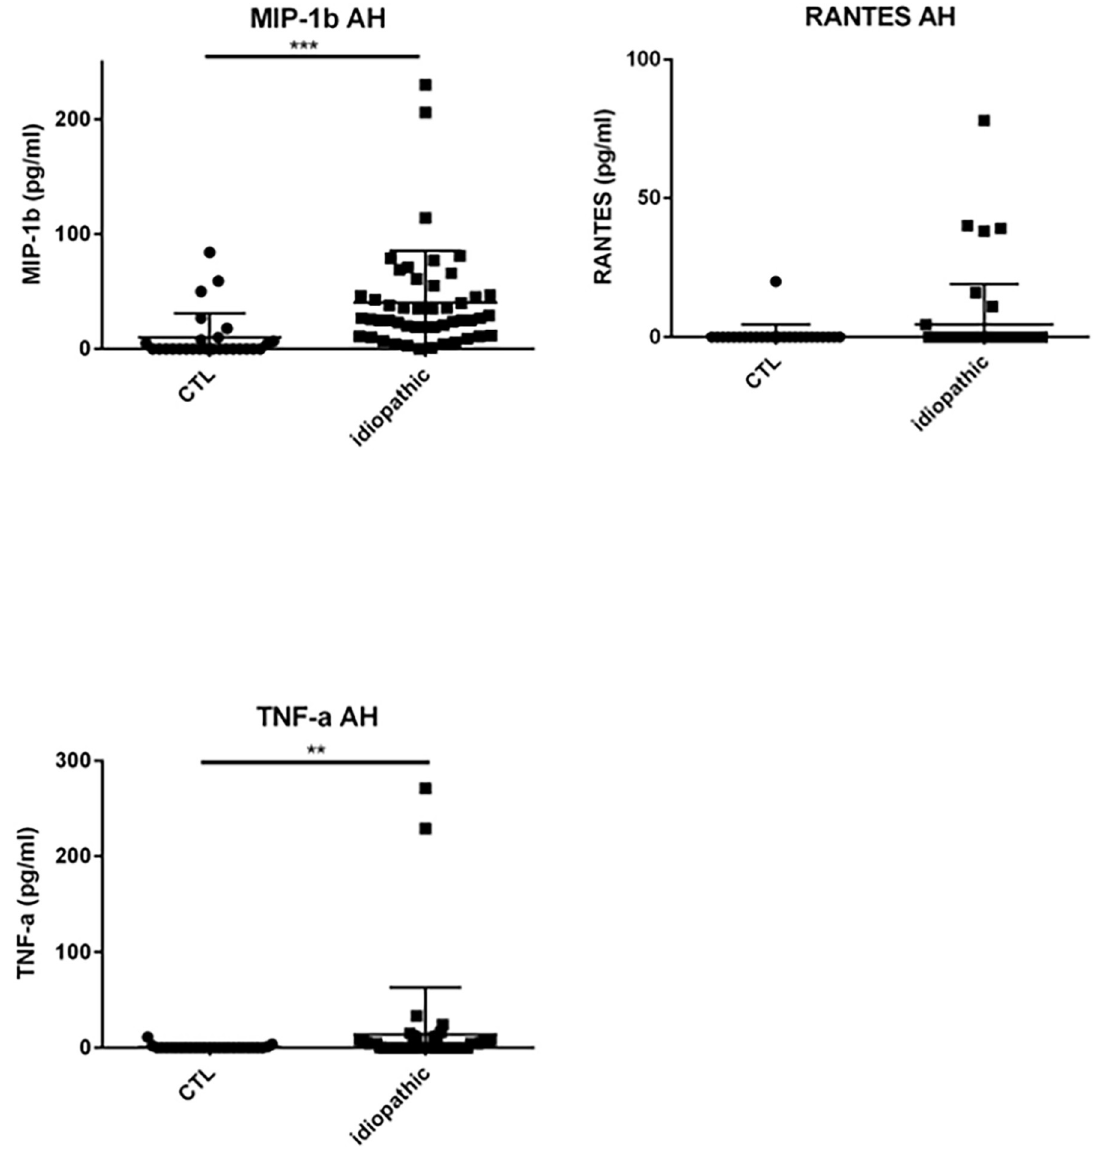
Fig 6. Dot plots of immune mediators: MIP-1 β , RANTES, TNF- α , in aqueous humor of patients with idiopathic uveitis (N = 64) as compared with immune mediators in the aqueous humor of noninflammatory controls patients (cataract age-related) (N = 36). Note that few isolated patients with idiopathic uveitis had an immune mediator elevated. � = P < 0.05 ; �� = P < 0.01; ��� = P < 0.001.